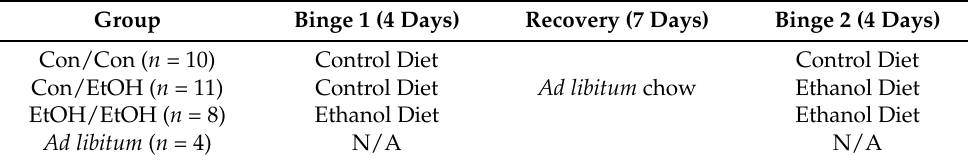
Table 1. Experimental